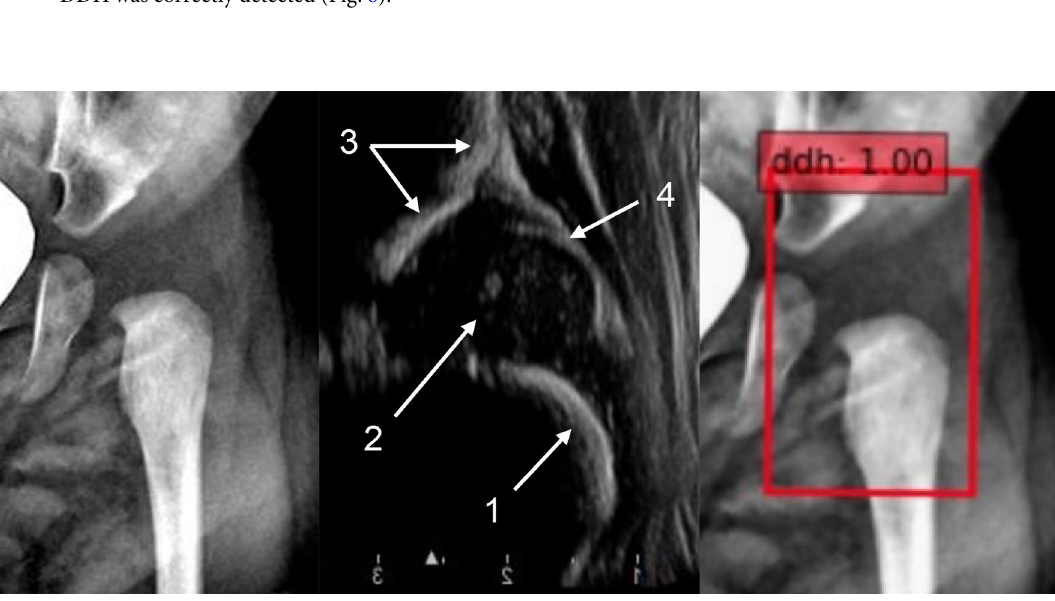
Figure 6. Hip anteroposterior radiography image (left), hip ultrasonography image of the same hip (middle), and the SSD model image output (right). The patient was a 1-month-old boy. IHDI grade 2, Graf type D. Anatomical interpretation of the ultrasonography image: 1, bony part of the femoral neck. 2, cartilaginous femoral head. 3, bony part of acetabular roof. 4, acetabular labrum. IDHI International Hip Dysplasia Institute, SSD Single shot multi-box